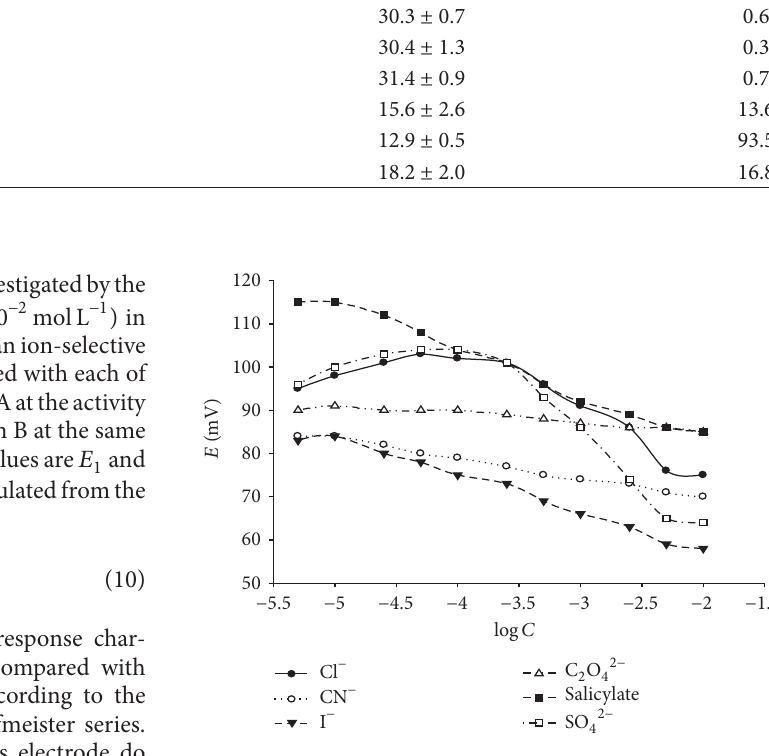
F 8: A schematic diagram of the electrode response to various interferences with FIM